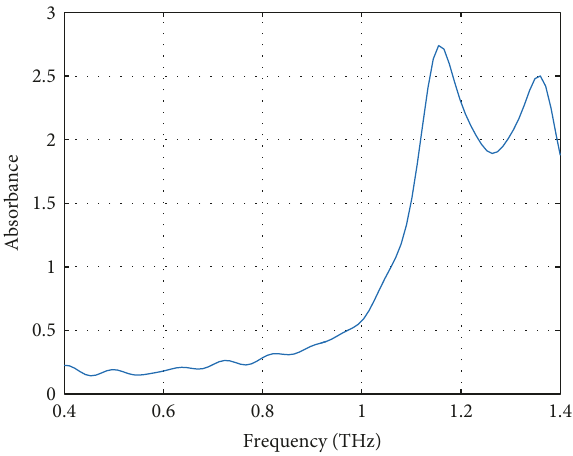
Figure 2: Average absorbance spectrum of pure